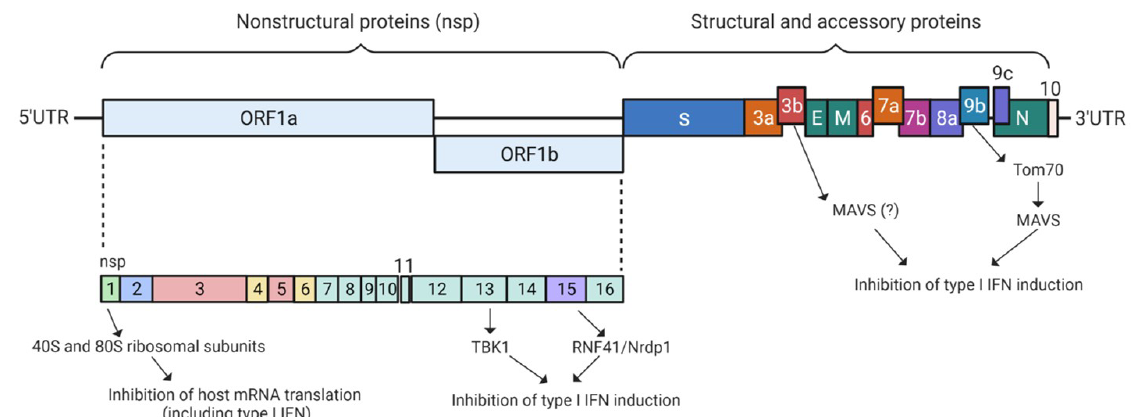
Figure 2. SARS-CoV-2 genomic organization and encoded non-structural and structural proteins. Different structural and nsps and possible mechanistic pathways have been identified that are involved in epigenetic subversion of the host anti-viral